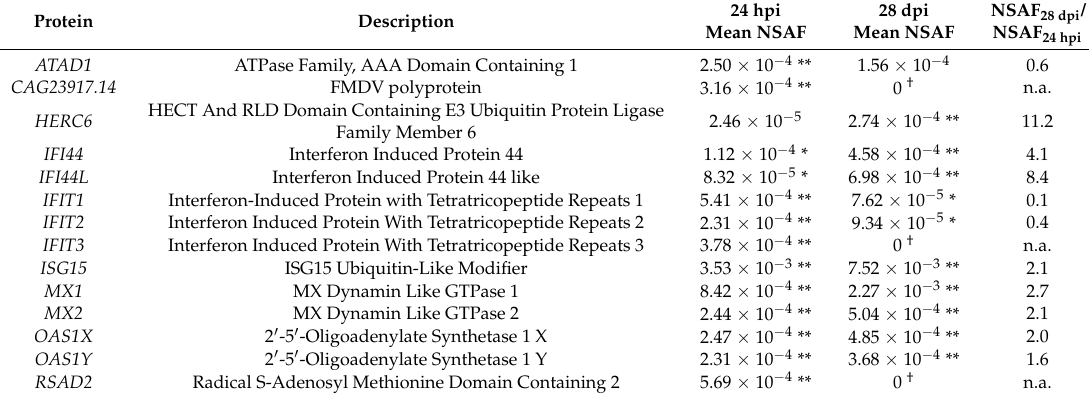
Table 3. Proteins with significantly different abundance at 24 hpi or 28 dpi. Only proteins that were also differentially expressed in the RNA sequencing experiment at the given time point are